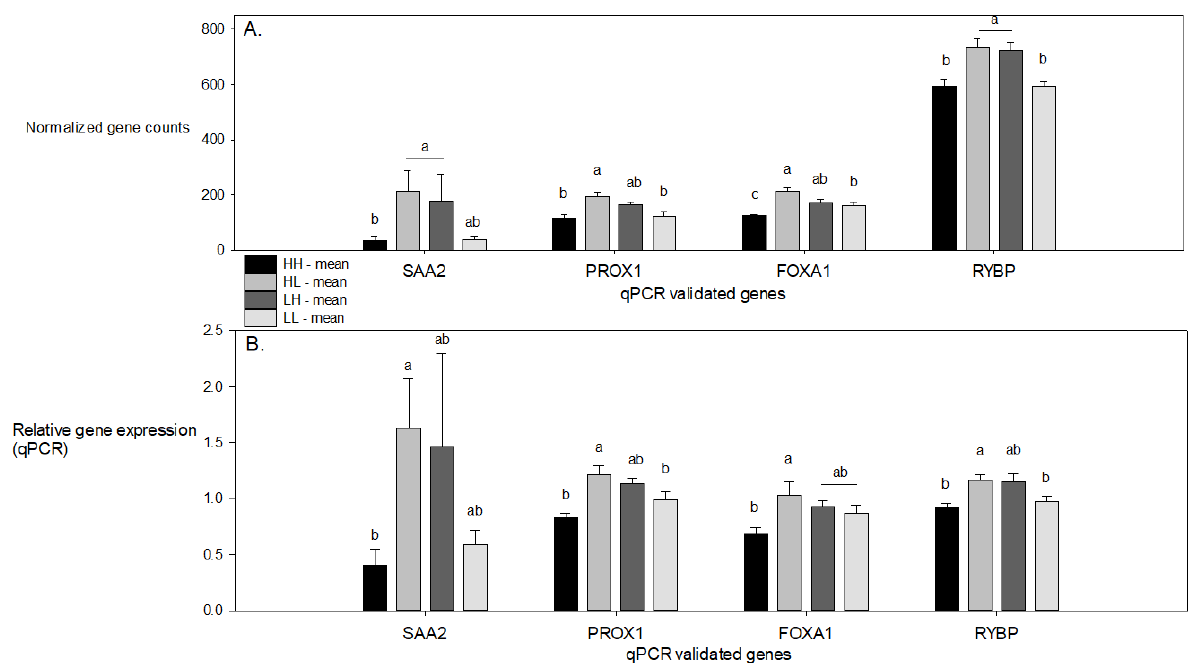
Figure 1. ( A ) Normalized gene counts of differential expressed genes (DEGs) in the RNA-seq counts for the four genes validated with qPCR with a standard error to the mean (SEM) indicated. Results are shown for each of the four treatment groups HH = higher (late gestation sow diet) − higher (nursery diet piglet) CP protein, HL = higher − lower CP protein, LH = lower − higher CP protein, and LL = lower − lower CP protein. ( B ) Relative DEGs for qPCR results. The significant differences between treatments ( p < 0.05) are denoted by a and b, were ab was not significantly different from either a or b.